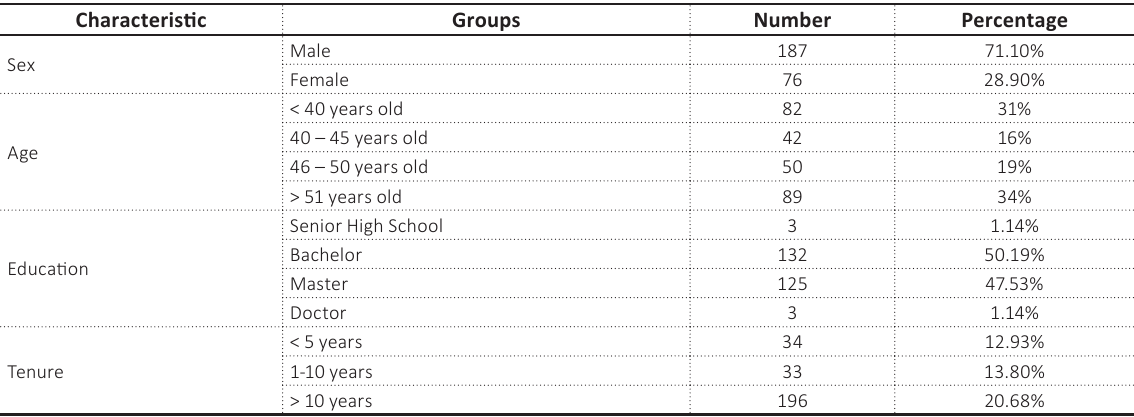
Table 1. Characteristics of